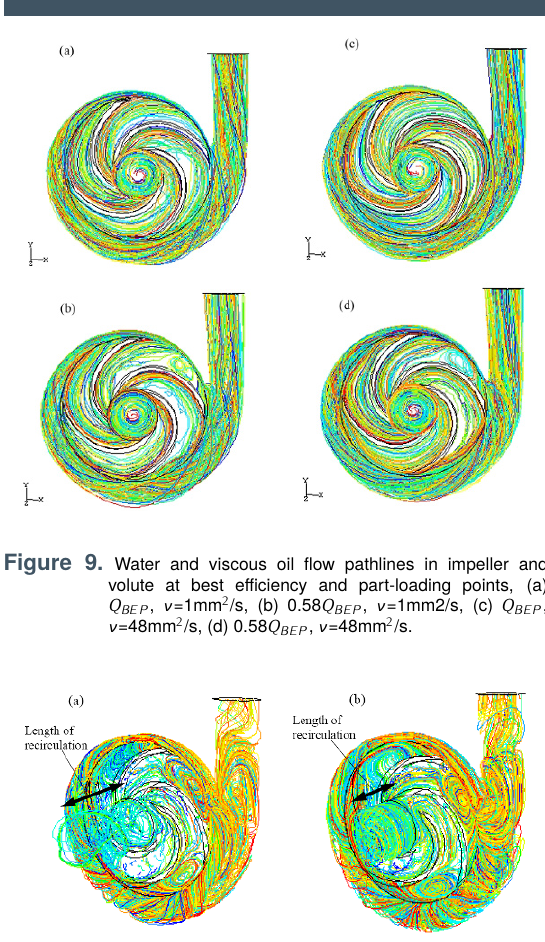
Figure 10. Water and viscous oil flow pathlines in impeller and vo- lute at shut-off condition, (a) ν =1mm 2 /s, (b) ν =48mm 2